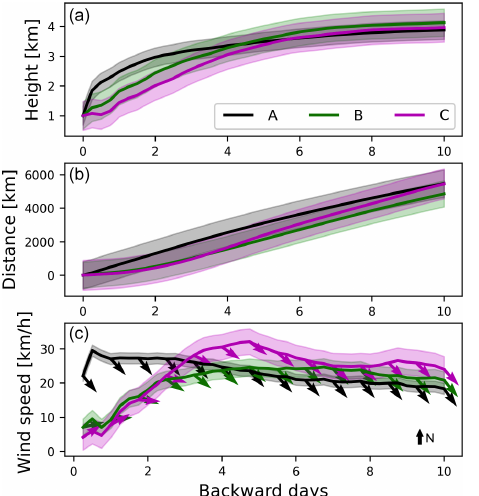
Figure 10. The mean (solid line) and SD (shaded area) of the air mass height (a) , the distance to the Xianghe site (b) , and the wind direction and speed (c) of categories A, B, and C simulated by the FLEXPART 10d backward running.